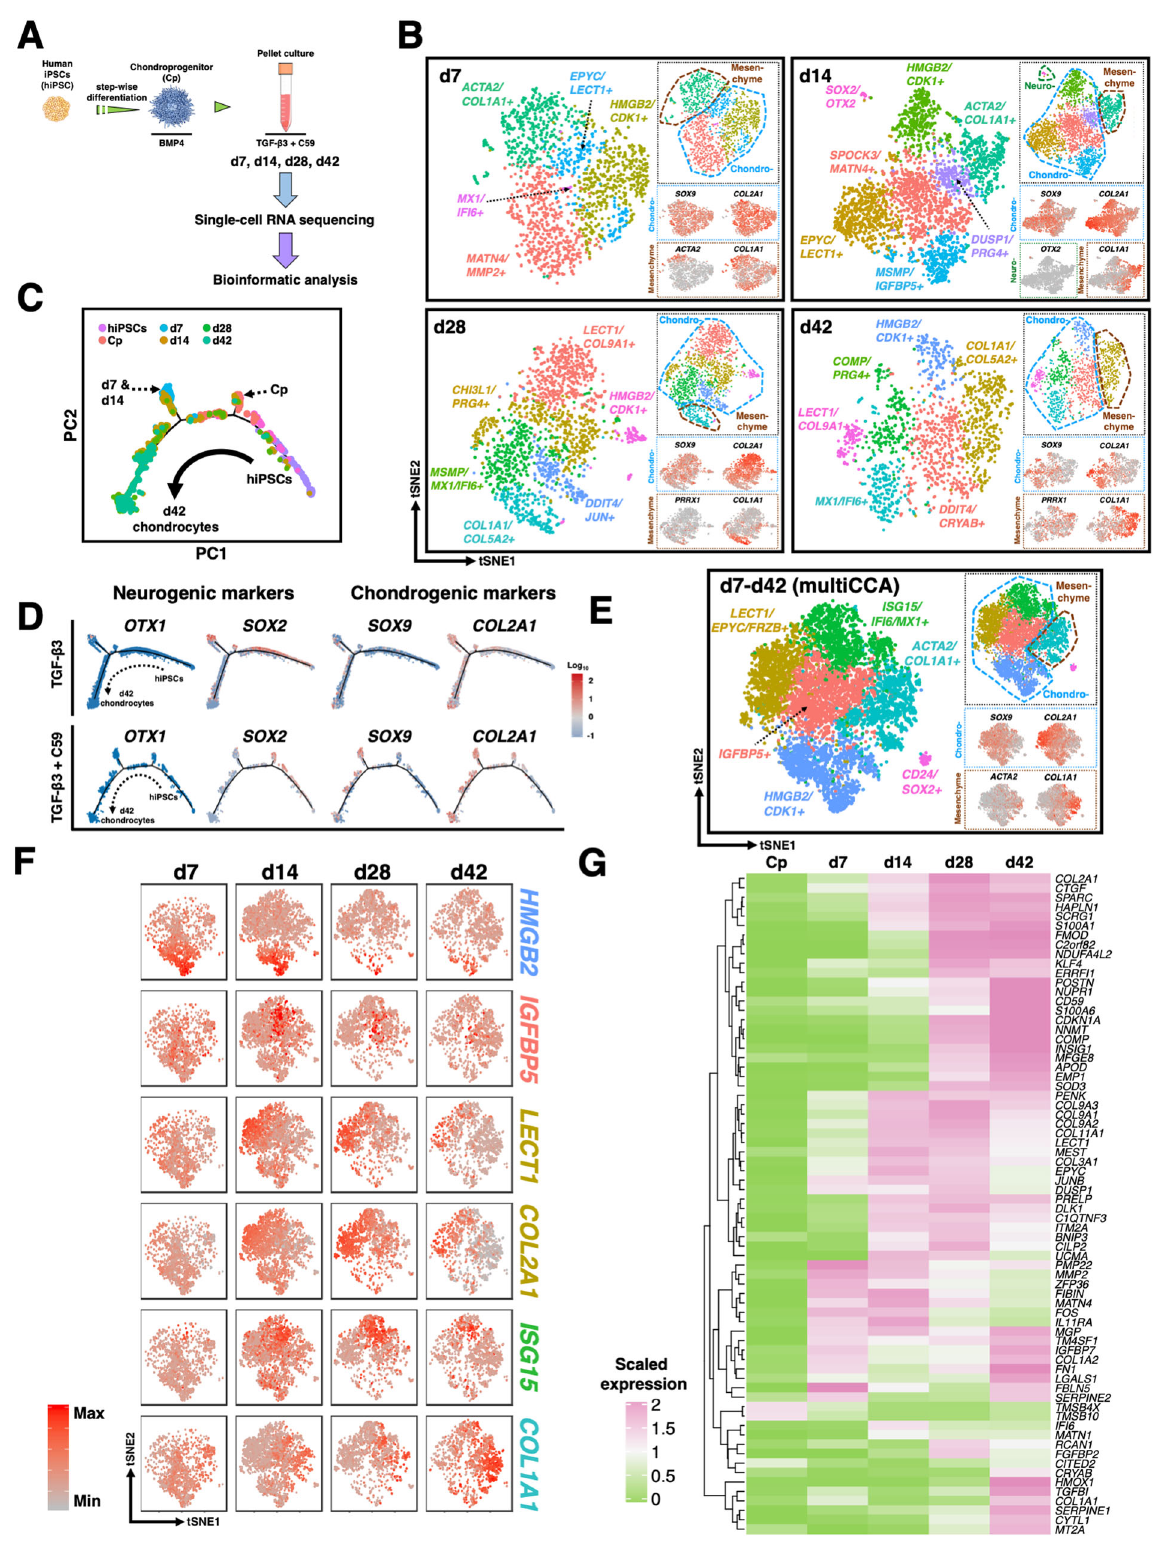
Fig. 5 scRNA-seq of pellets with WNT inhibition shows improved chondrogenesis. A scRNA-seq was performed on the pellets with WNT inhibition. B Chondrocytes and mesenchymal cells were two major populations in C59-treated pellets. Cells that passed quality control were used for tSNE plots; hiPSC: 4798 cells, Cp: 1888 cells, d7: 1682 cells, d14: 3076 cells, d28: 1756 cells, and d42: 1483 cells. C Differentiation trajectory of C59-treated pellets. scRNA-seq data with a total of 14,683 cells from the stage of hiPSC, Cp as well as d7, d14, d28, and d42 C59-treated pellets were used to reconstruct the differentiation trajectory. D C59-treated pellets exhibited decreased neurogenic markers but increased chondrogenic markers. E Multiple CCA alignment of d7 – d42 pellets. A total of 7977 cells from d7 – d42 timepoints of C59-treated pellets were used to perform CCA alignment. F Dynamic changes in gene expression and percentages of chondrocyte subpopulations over time. G Heat map of top 20 DEGs at each timepoint for LECT1/EPYC/FRZB + early mature chondrocytes. NATURE COMMUNICATIONS| (2021) 12:362 |https://doi.org/10.1038/s41467-020-20598-y|www.nature.com/naturecommunications